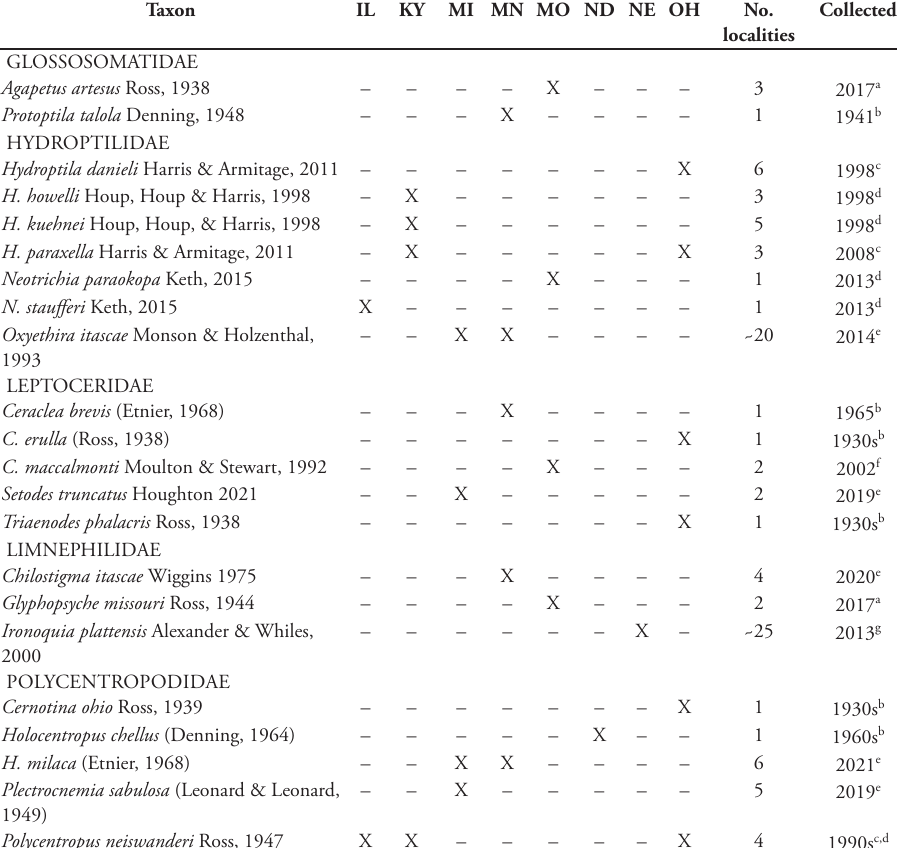
Table 2. The 22 species that are global endemics to the Upper Midwestern region, organized by family and genus, and with known number of collection localities and recent collection year. Superscript references are after the